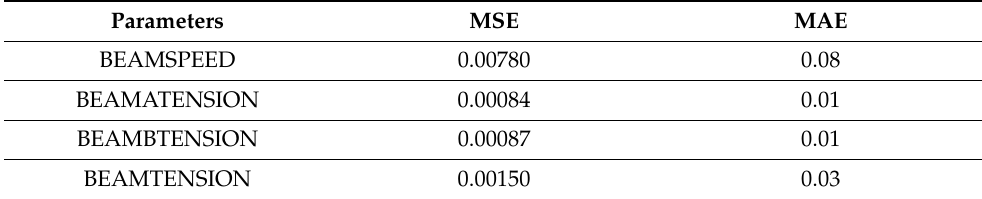
Table 18. Elastic Net results for the beaming process.